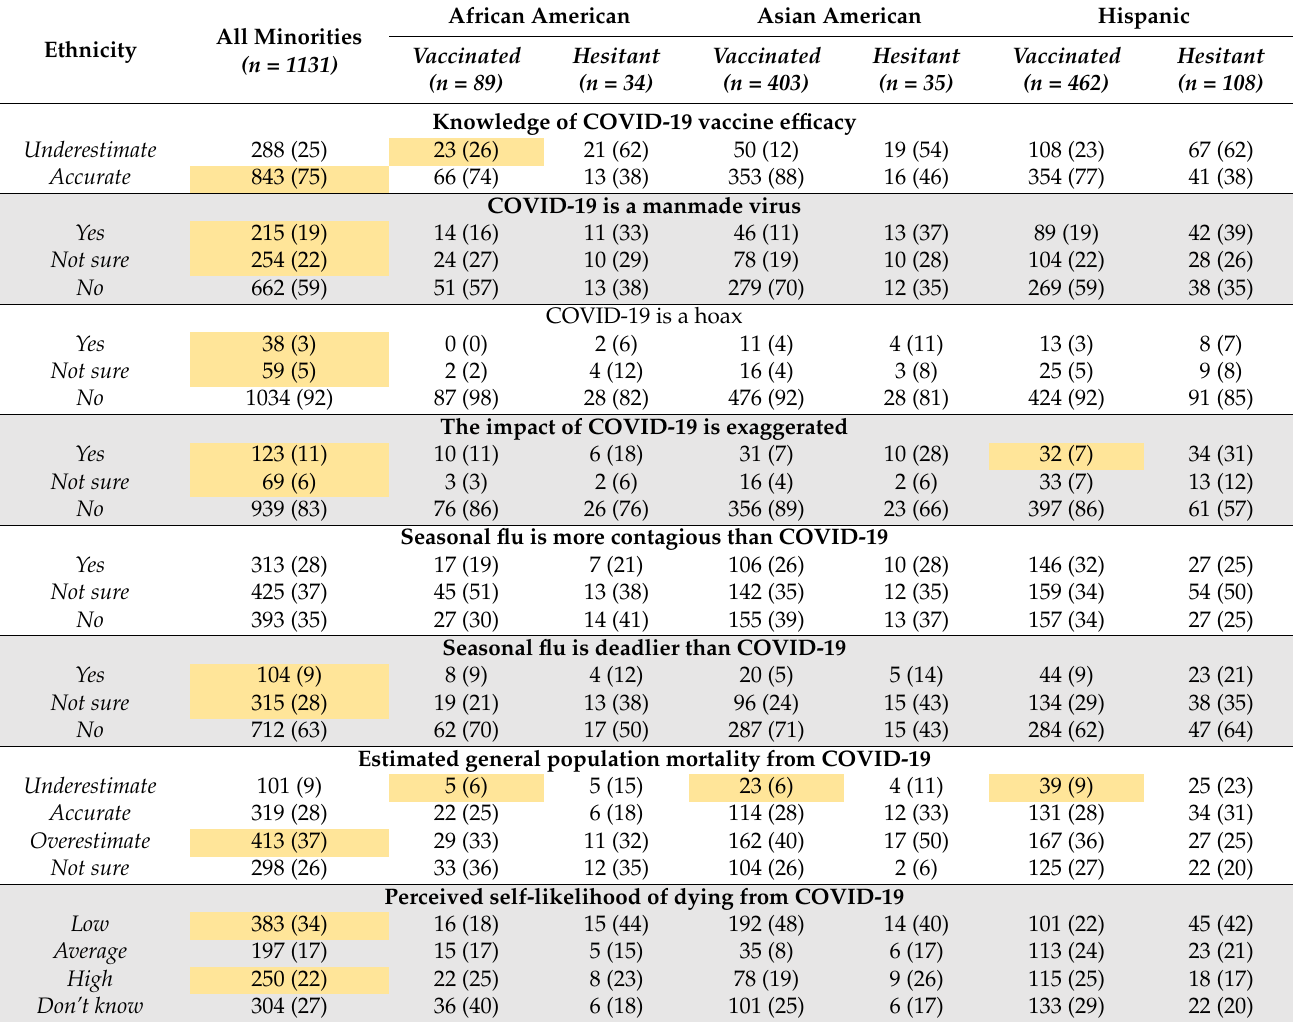
Table 2. Ethnic differences regarding various COVID-19 virus and COVID-19 vaccine beliefs amongst health care workers. Results are reported as Count (Percent) in each column. Notable differences shaded in